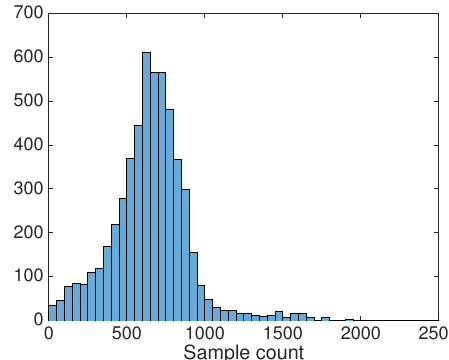
Figure A1. Distribution of OIB sample count ( M